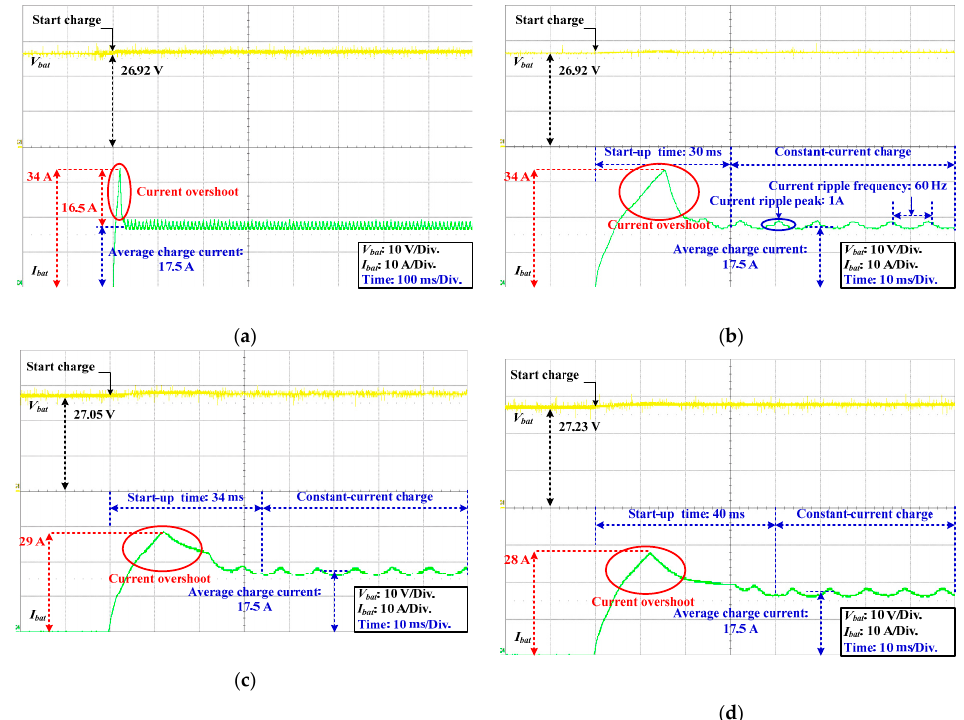
Figure 23. Using PI control and setting f zc = 49 Hz. ( a ) Start-charge voltage: 26.92 V, SOC: 30%, time scale: 100 ms/div. ( b ) Start-charge voltage: 26.92 V, SOC: 30%, time scale: 10 ms/div. ( c ) Start-charge voltage: 27.05 V, SOC: 50%, time scale: 10 ms/div. ( d ) Start-charge voltage: 27.23 V, SOC: 70%, time scale: 10 ms/div. Electronics 2018 , 7 , x FOR PEER REVIEW